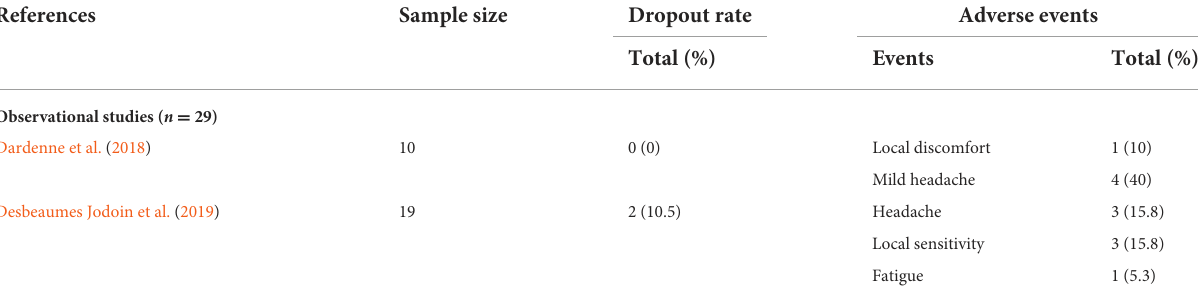
TABLE 3 Dropout rate and adverse